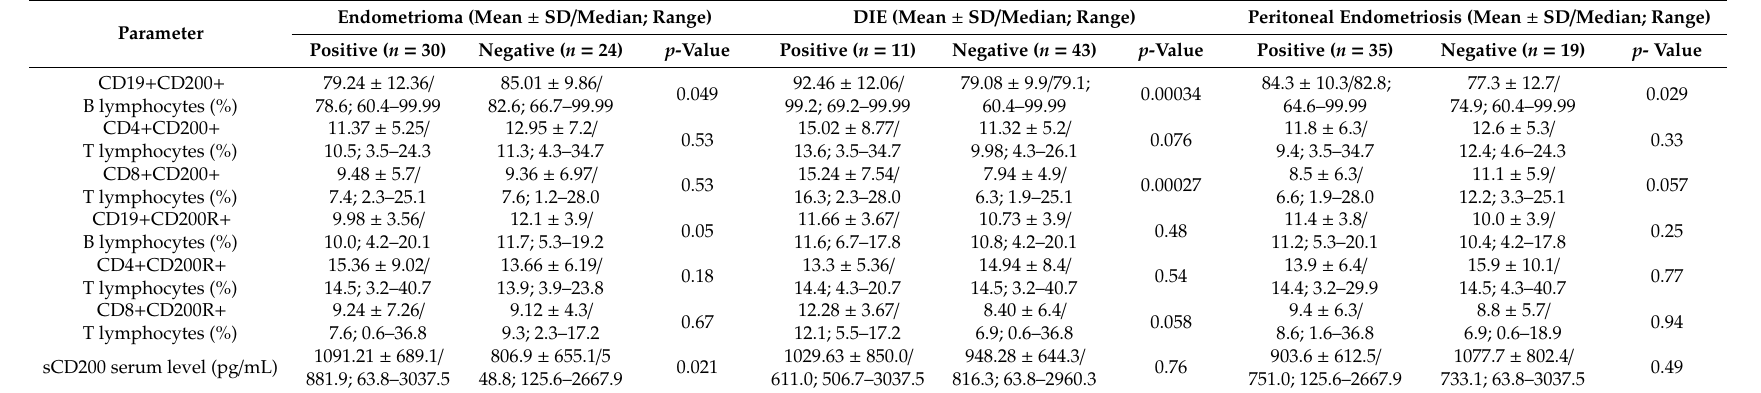
Table 4. The sCD200 concentration and frequencies of CD200 and CD200R on T and B lymphocytes in patients with di ff erent types of EMS: Endometrioma, deep infiltrating EMS, and peritoneal